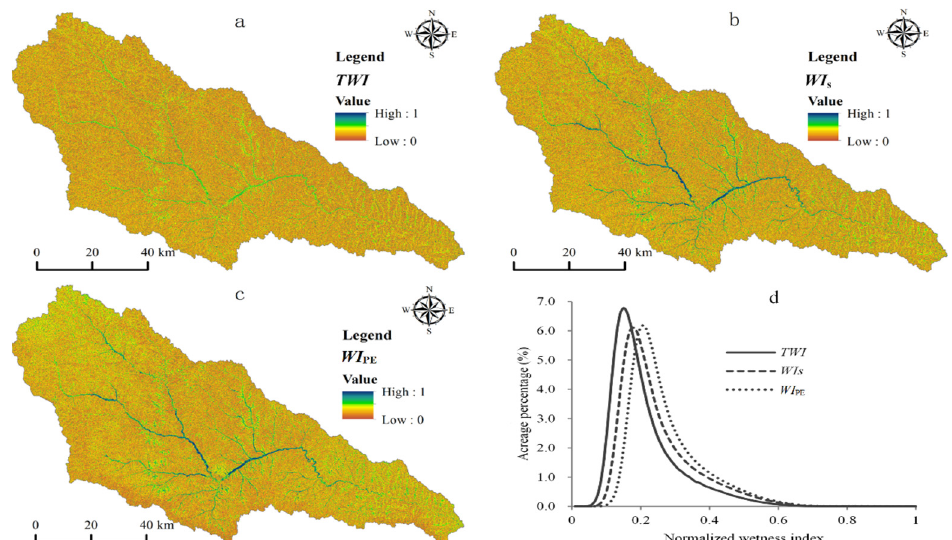
Figure 4. Spatial distribution of normalized wetness index in Yan River watershed: ( a ) normalized topographical wetness index ( TWI ), ( b ) normalized SAGA (System for Automated Geoscientific Analyses) wetness index ( WI S ) and ( c ) normalized wetness index ( WI PE ), and ( d ) the acreage distribution of the three normalized wetness indices.